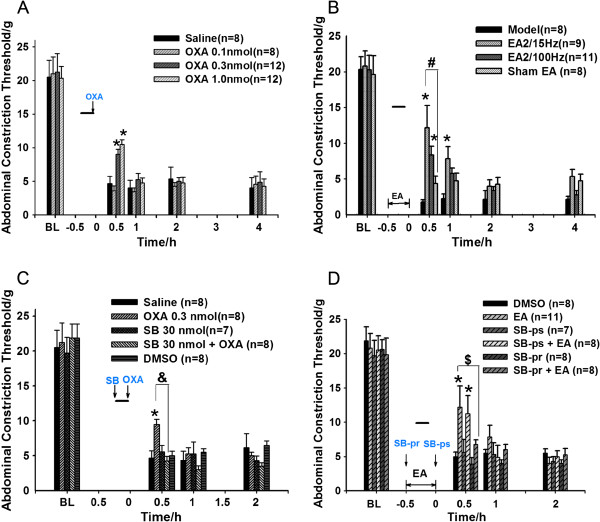
Effect of post-surgical OXA injection (A) and perioperative EA (B) on the rat model of post-laparotomy pain, and effect of SB-334867 on OXA analgesia (C) and EA analgesia (D). Data are presented as the mean ± SEM at the indicated time points post-surgery. *P<0.05 versus the saline/model/DMSO group. #P<0.05 versus the sham EA group, &P<0.05 versus the SB-334867 + OXA group, $P<0.05 versus the EA group. Short black line represents the surgery duration. The double-headed arrow represents the EA duration. BL: baseline. SB-pr: pre-surgical injection of SB-334867; SB-ps: post-surgical injection of SB-334867.